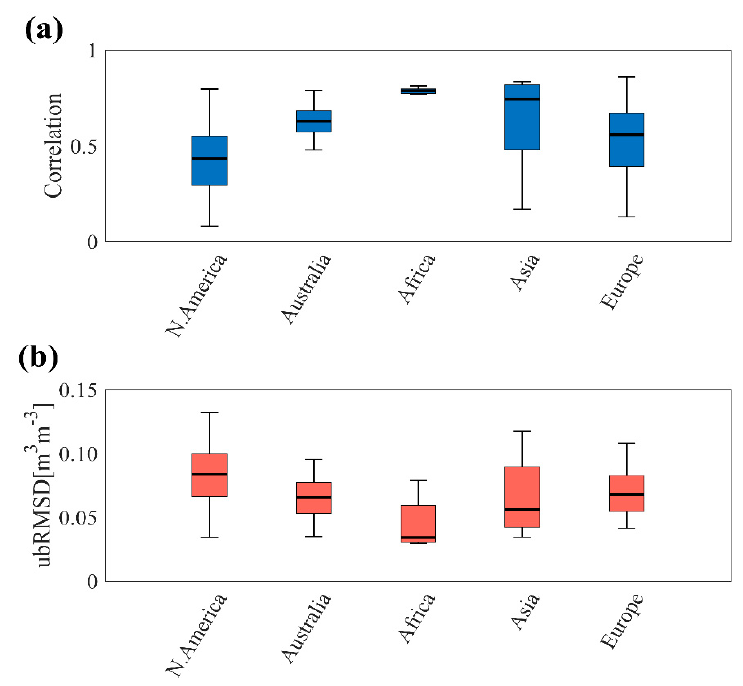
Figure 5. Detailed ( a ) correlation and ( b ) ubRMSD results showing the performance of the merged product over the different continents.